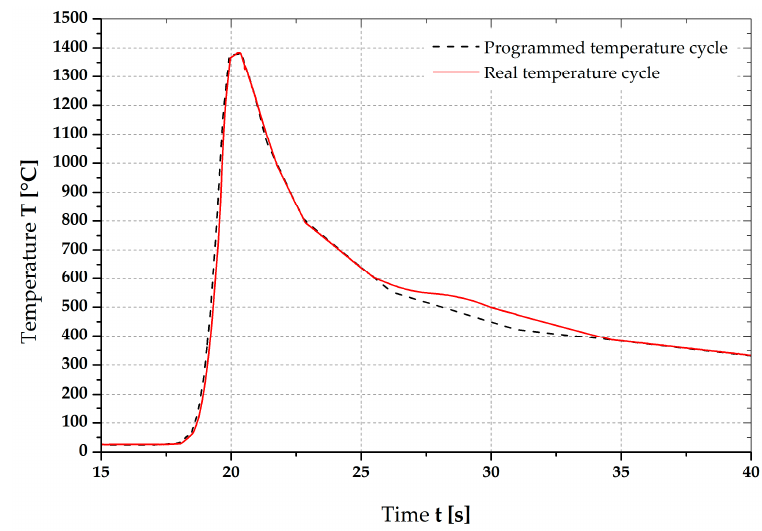
Figure 13. Comparison of the programmed (black dashed line) and the real (red line) applied temperature cycle.